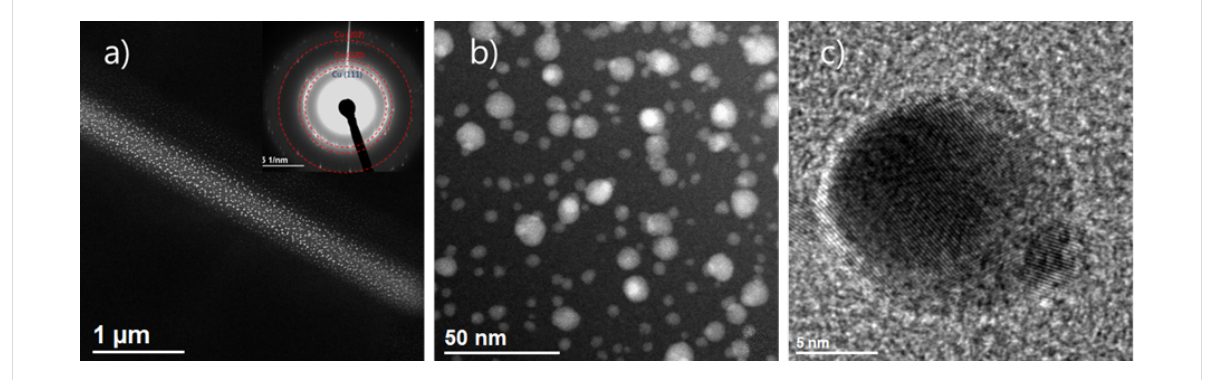
Figure 6: In situ TEM annealing for 10 min at 220 °C on a line deposit from Cu(hfac) 2 shown in Figure 2. a) STEM high angle annular dark field (STEM-HAADF) image of Cu nanocrystals forming from the deposit material. b) HAADF image showing distribution of Cu nanocrystals. c) High-resolution TEM (HR-TEM) image of 15 nm sized polycrystalline Cu precipitate. The inset shows the SAD pattern of Cu fcc